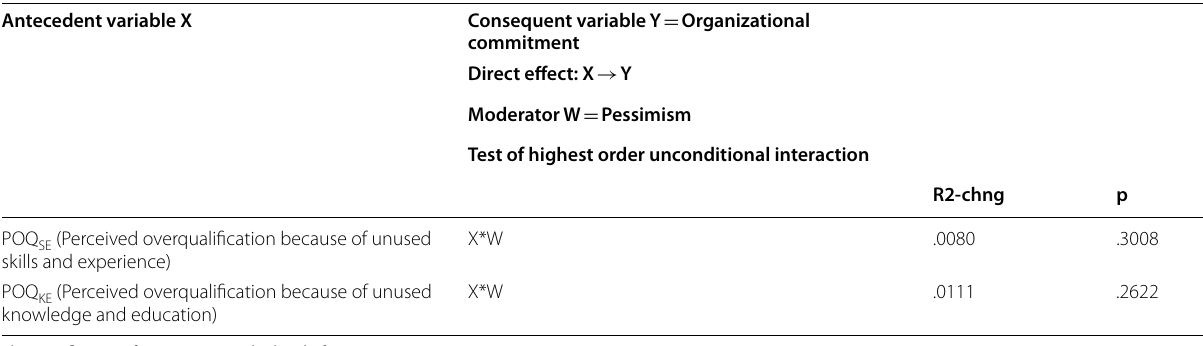
Table 7 Moderated direct effect of POQ (Perceived overqualification because of unused skills and experience)/ POQ SE overqualification because of unused knowledge and education) on Organizational commitment — Pessimism as a moderator